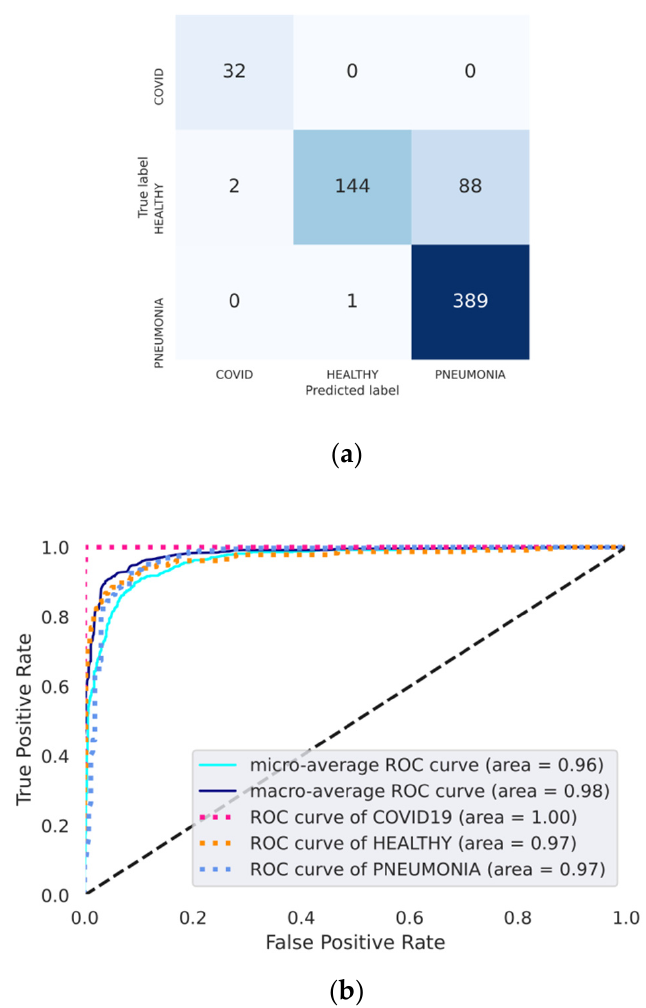
Figure 9. Results obtained for the classification of the test set using the proposed model. ( a ) Shows the confusion matrix of the three classes; ( b ) shows ROC curves scores.